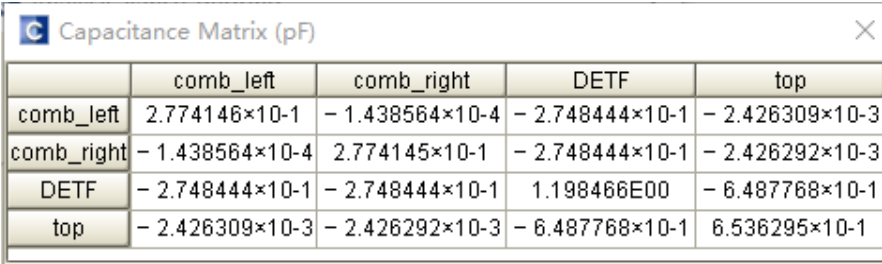
Figure 13. Interface capacitance simulation.